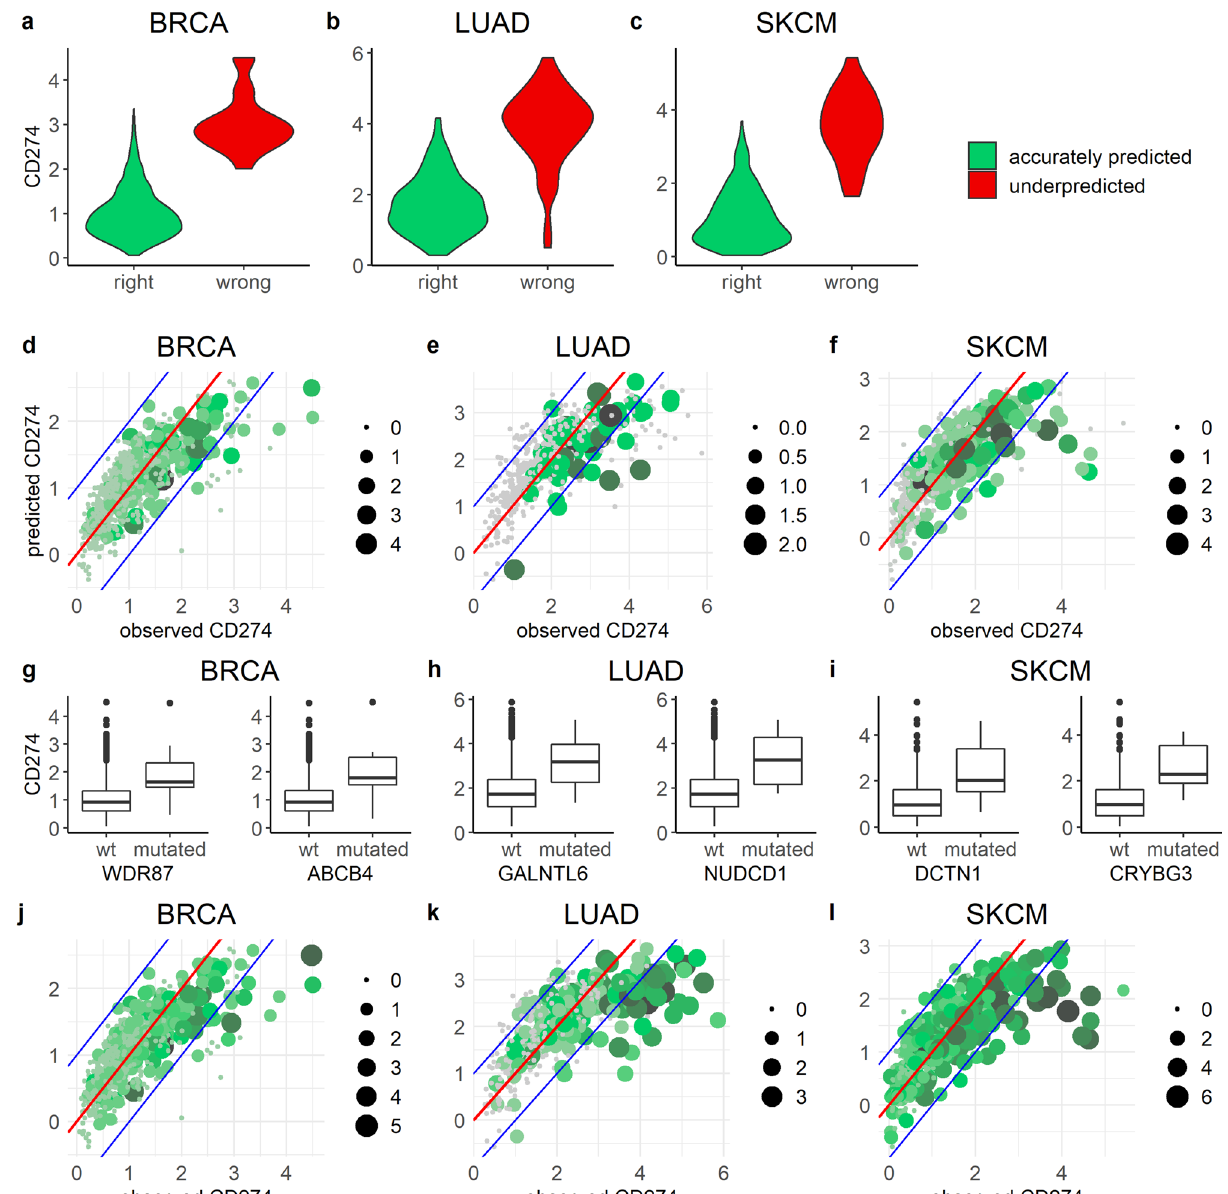
Figure 3. Mutations partially explain patients with high CD274 expression. ( a–c ) Violin plot comparing CD274 expression between accurately predicted and underpredicted patient groups. ( d–f ) Total mutation count in individual patients for earlier established critical genes that are based on only the accurately predicted group. ( g–i ) Examples of mutations leading to elevated CD274 expression based on the total patient population. ( j–l ) Total mutation count in individual patients for critical genes that are based on the total patient population. Both dot size and color indicates the log2 of the total number of mutations in critical genes. In all panels the cancer type is indicated above the